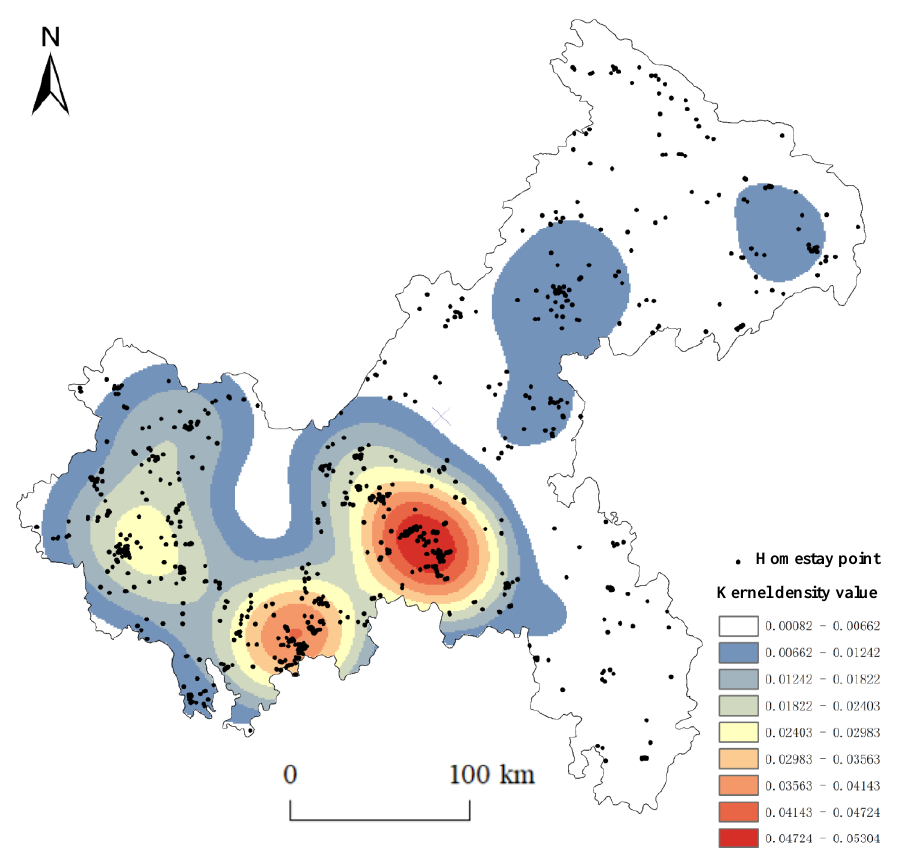
Figure 4. Density of homestay nuclei in Chongqing. Note: Based on the standard map (scale: 1:48 million) with the approval number of GS (2019) 1823 on the standard map service website, the base map was not modified.